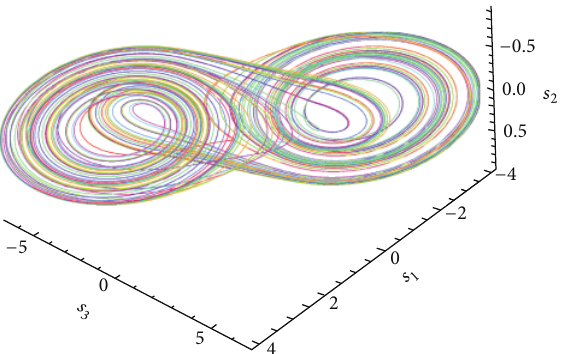
Figure 1: Simple directed complex network with 12 nodes.